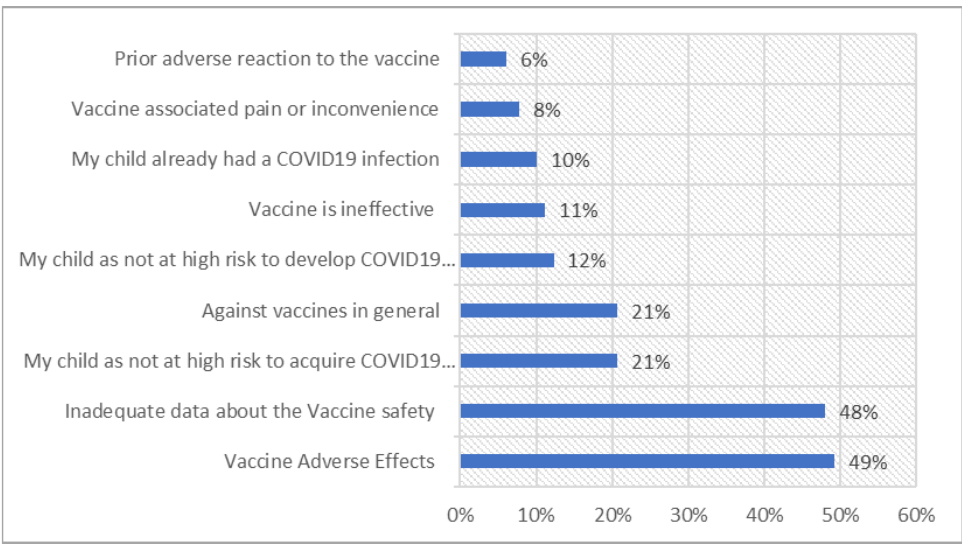
Figure 2. Reasons for parental avoidance of the COVID-19 vaccine in children (n = 179). Almost half of them were concerned about potential side effects on their child or believed that there is inadequate information on the safety of the COVID-19 vaccines. Another 20.7% of them suggested that they are against the vaccine in general and/or believed their child is not at high risk for acquiring the disease. On the other hand, participants who vaccinated their children or planned to vaccinate them were asked for the motives for vaccinating their children against COVID-19 (Figure 3).